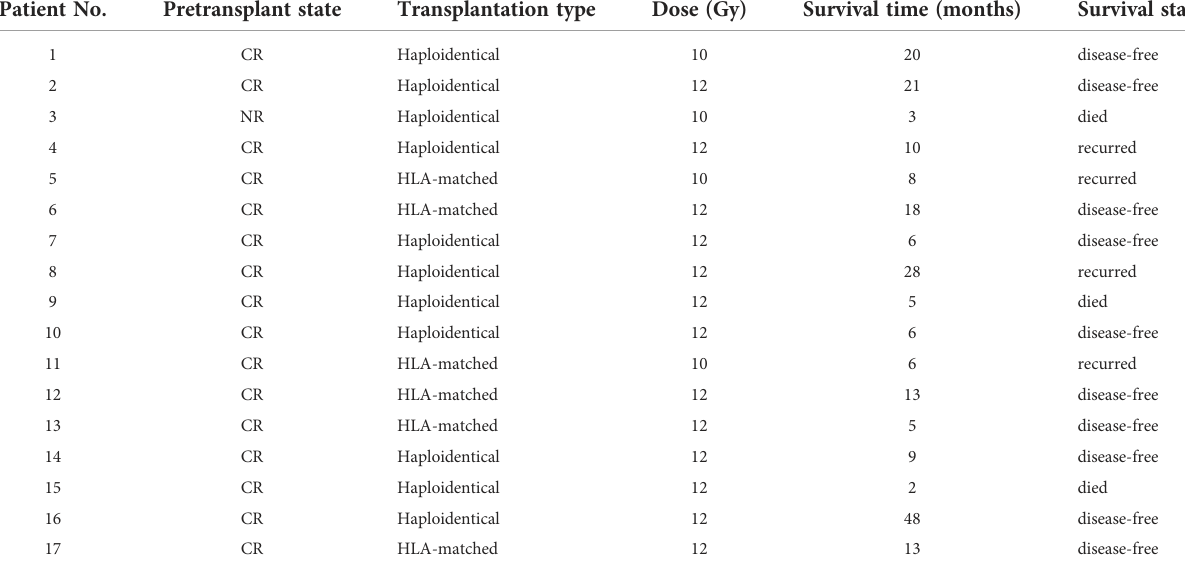
TABLE 4 Disease condition of patients before and after transplantation and survival time after transplantation. Patient